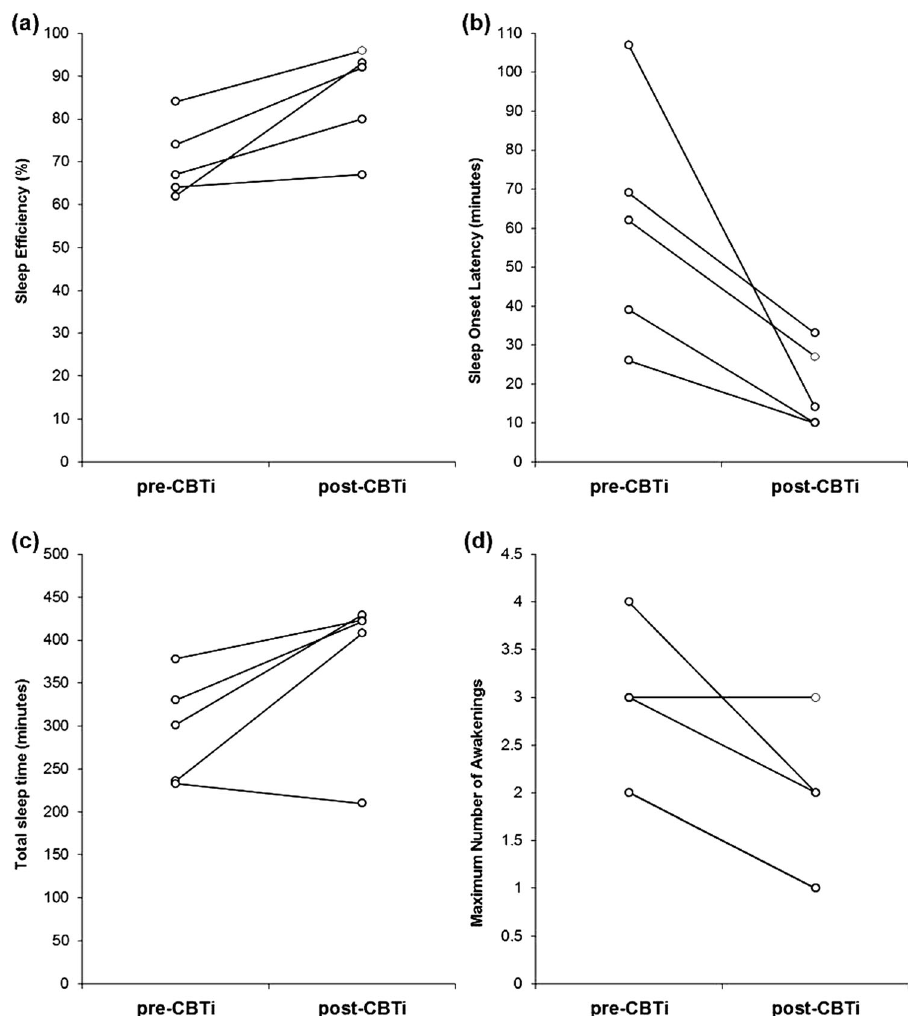
Fig. 1 Within-subject changes post-CBTi compared to pre-CBTI in the following self-reported sleep measures: a sleep-ef fi ciency b sleep onset latency c total sleep time d maximum number of nocturnal